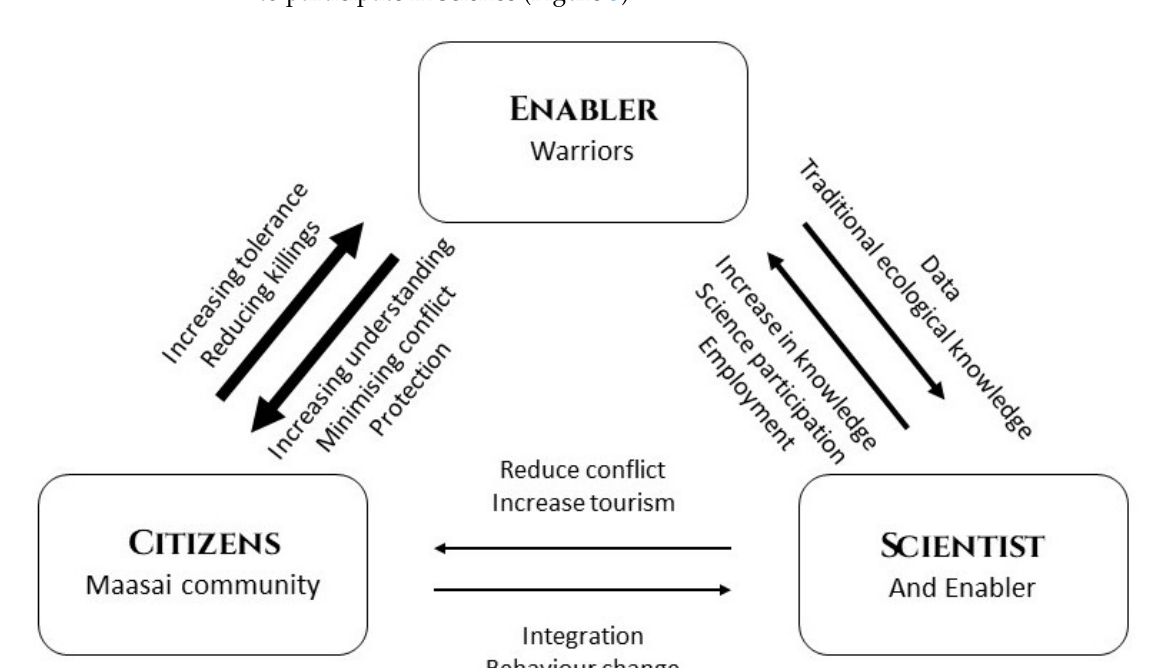
Figure 3. The tripartite model of citizen science applied to the Lion Guardians. Line thickness indicates strength of the provided service. Boxes indicate different roles. While the scientist also played a role as an enabler (in the form of an initiator or activist advocating for behavior change), the Maasai warriors were identified as the key enablers that acted as a bridge between the scientist and the wider community.